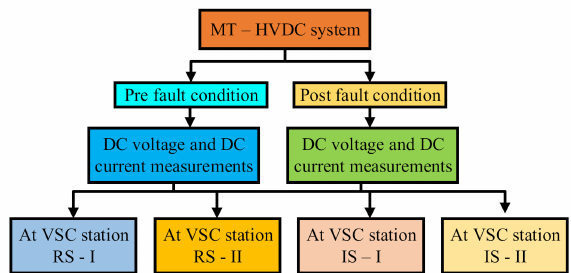
Figure 11. Pre-fault and post-fault measurements at VSC stations of the HVDC test system under study.